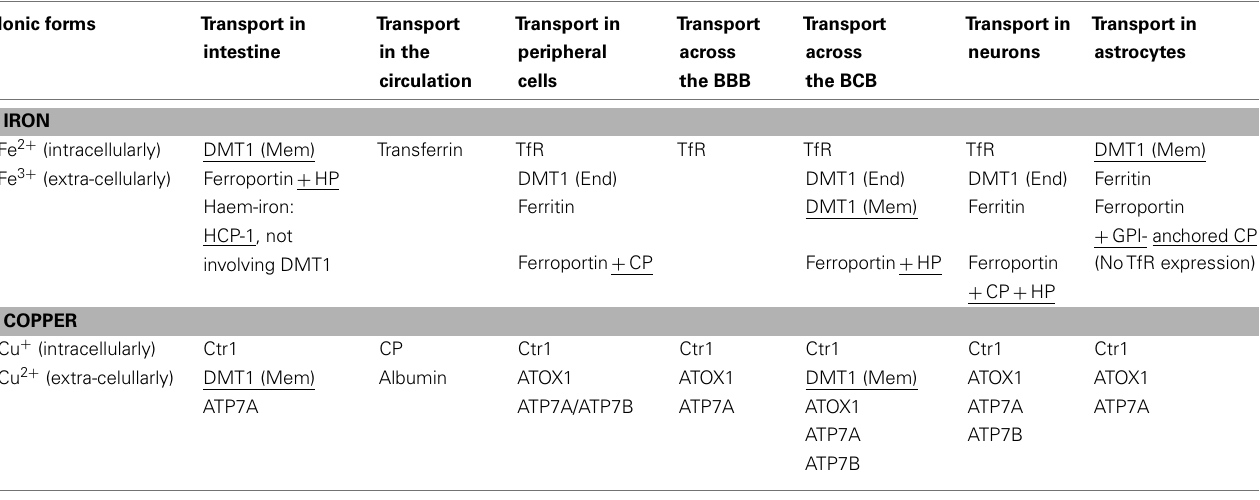
Table 1 |Transporters involved in transport of iron and copper, respectively, in different cell types. Ionic